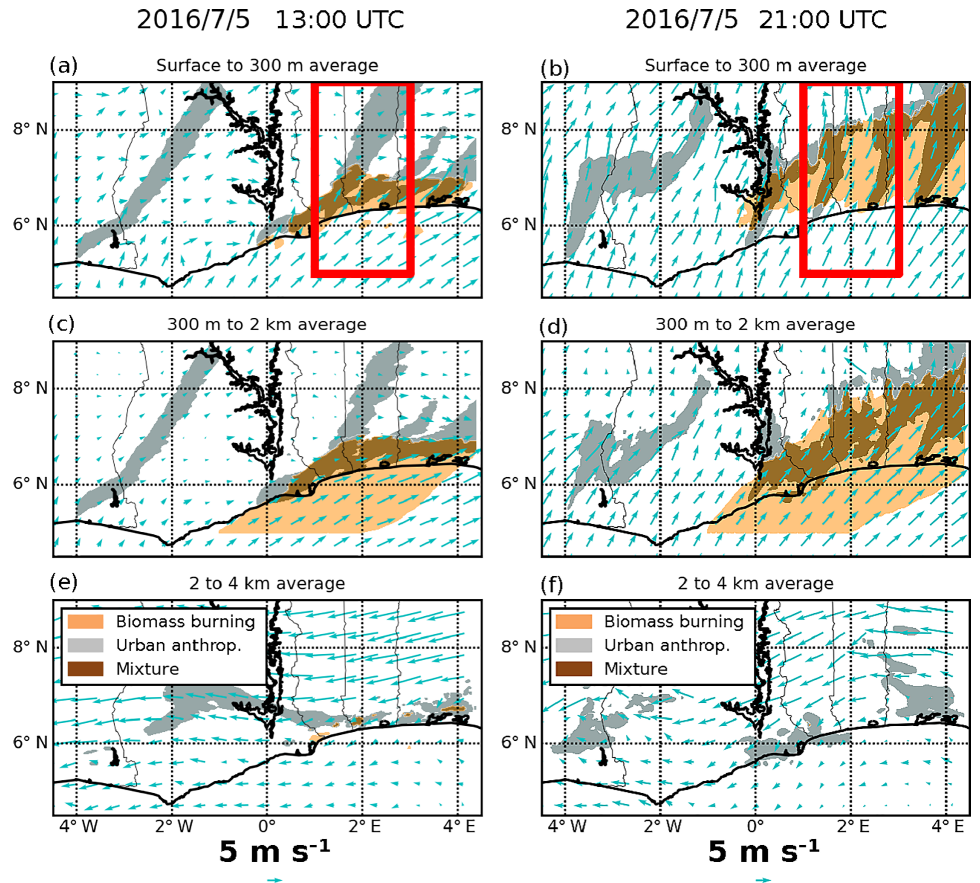
Figure 9. Maps of concentrations of URB (in gray) and BB (in brown) numerical tracers on 5 July 2016 at 13:00UTC (column a, c, e ) and at 21:00UTC (column b, d, f ). Concentrations are averaged over three layers (a, b) from the surface to 300ma.m.s.l., (c, d) from 0.3 to 2kma.m.s.l., and (e, f) from 2 to 4kma.m.s.l. Wind vectors at 10m from the WRF model are presented by the light blue arrows. The meridional–vertical transect shown in Fig. 10 corresponds to the zonally averaged area of the red